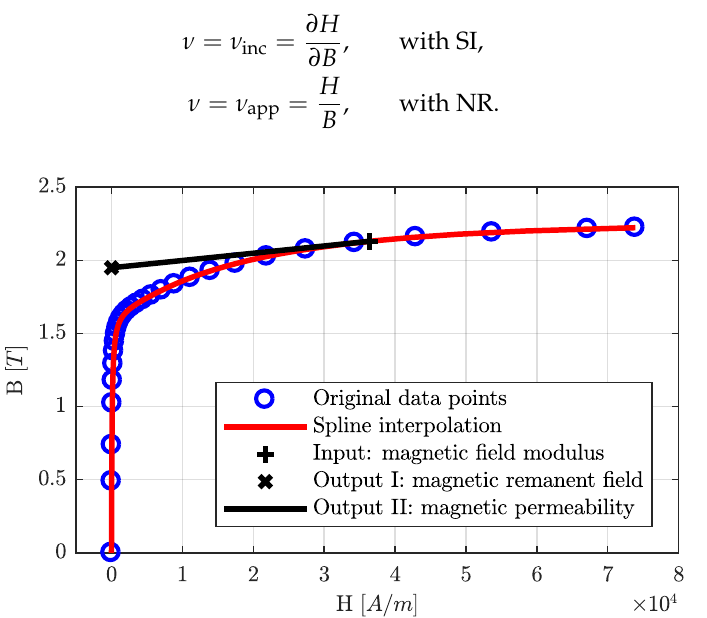
Figure 1. Graphical representation of the SI algorithm. Underlying BH -curve corresponds to the soft-magnetic material Cogent M800 50Hz 50A